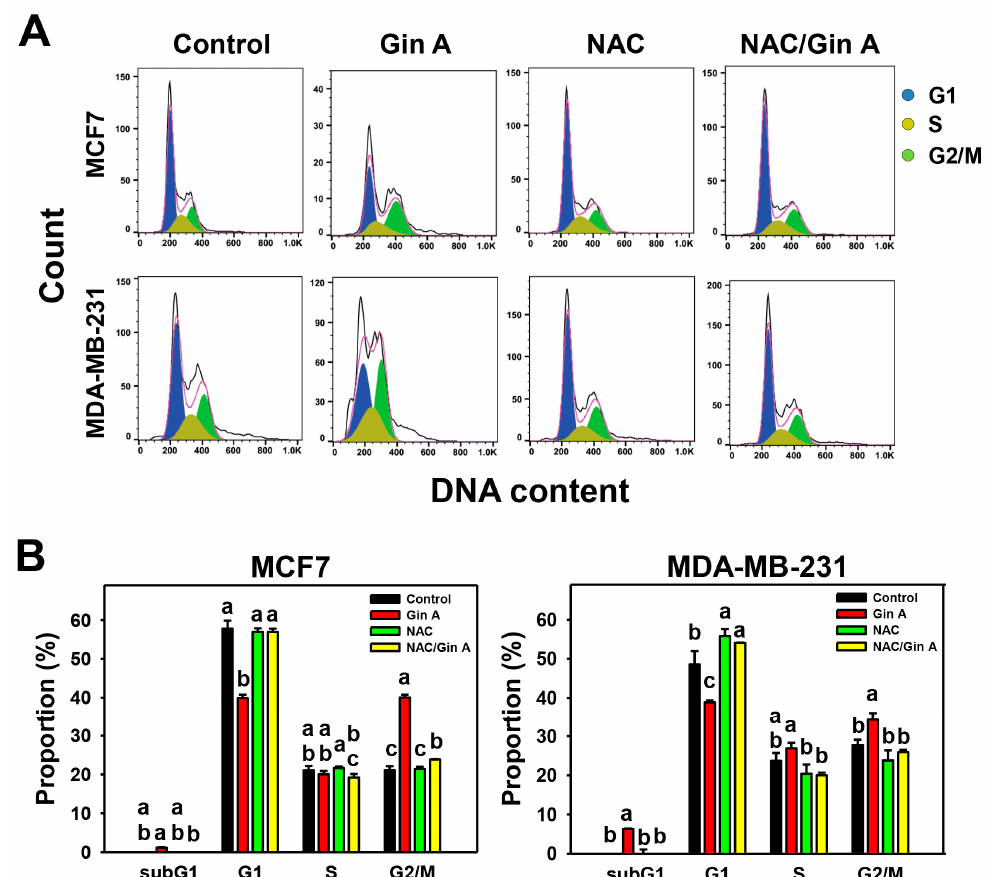
Figure 2. Impact of Gin A on cell cycle of breast cancer cells. ( A , B ) NAC reverted the effects on cell cycle disturbance. Cells were pretreated with NAC (10 mM) for 1 h and then post-treated with Gin A (control and 80 µ M) for 48 h, namely NAC/Gin A. Data, means ± SDs ( n = 3). When the connecting letters are overlapping, their difference was significant for multiple comparisons ( p < 0.05 to 0.0001).